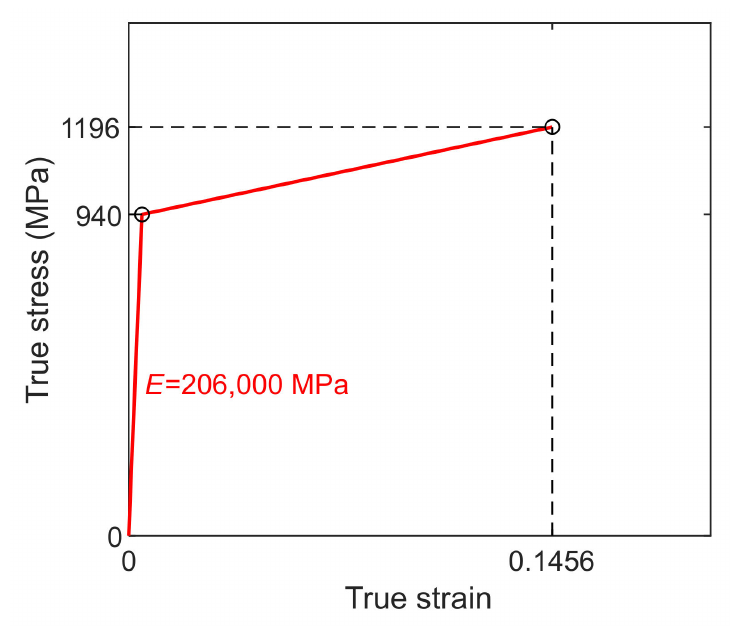
Figure 4. Stress–strain model of high-strength